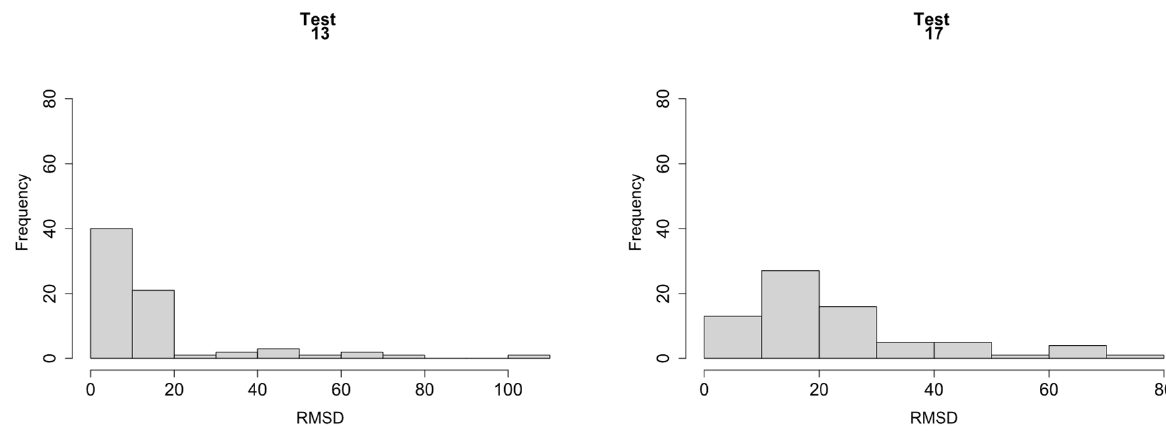
Figure 6. RMSD histograms.